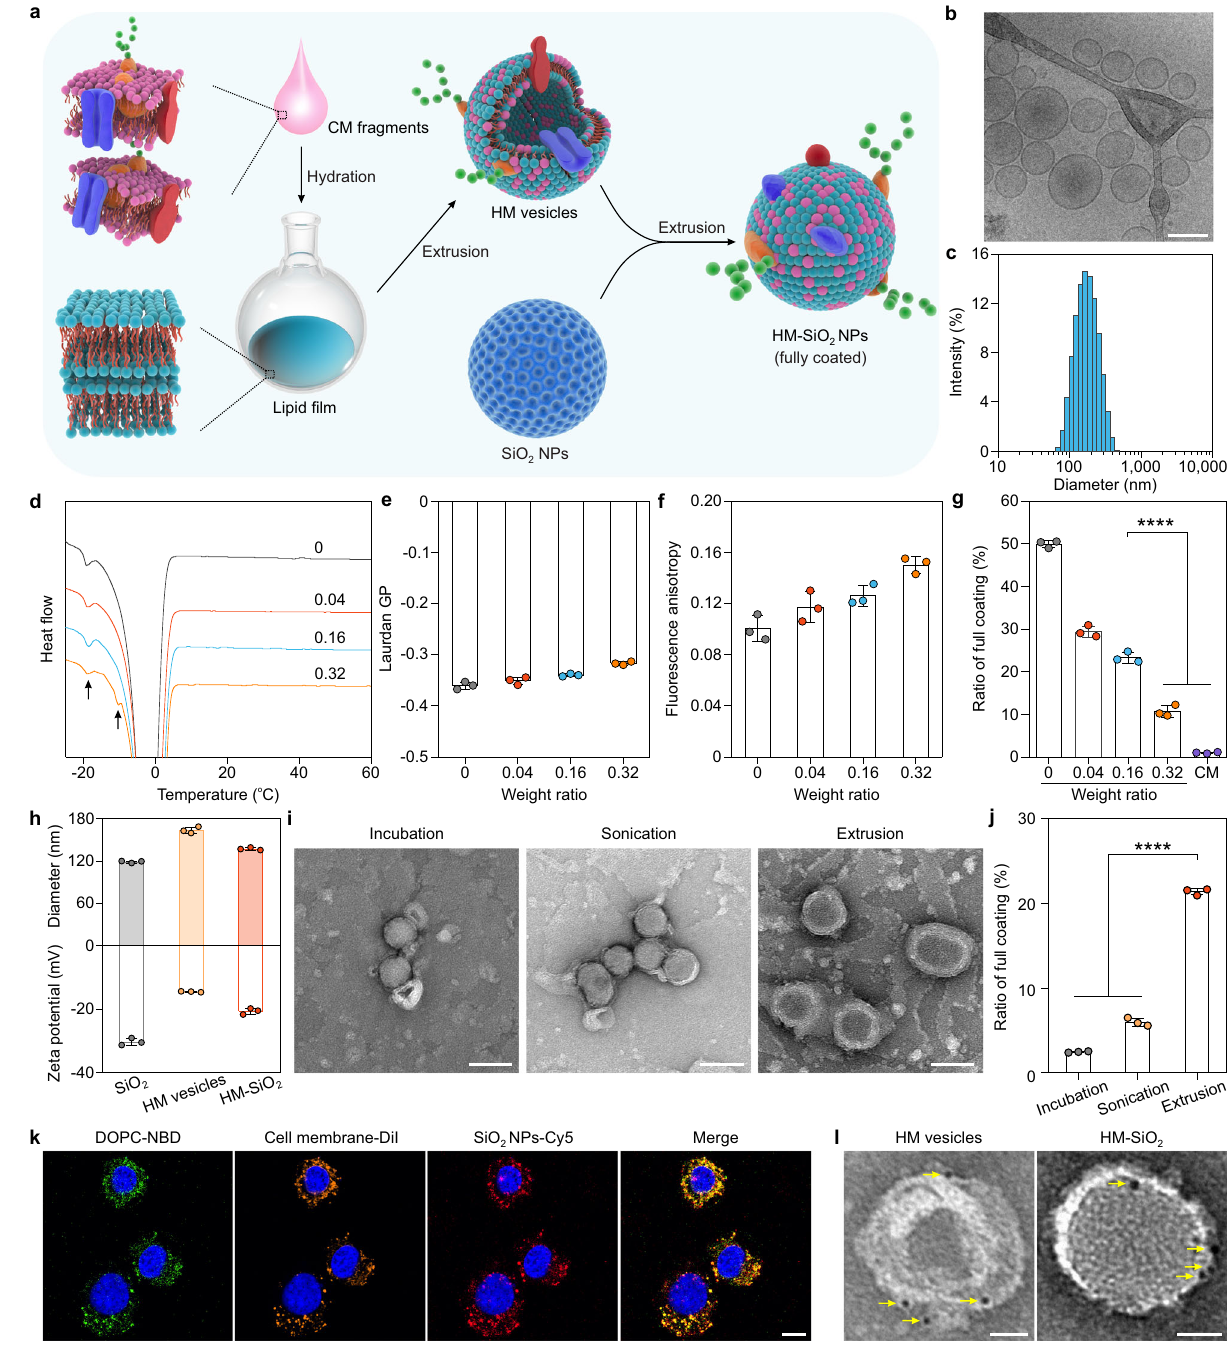
Fig. 4 | Preparation and characterization of HM-SiO 2 NPs. a Schematic showing the process of developing fully coated HM-SiO 2 NPs. b Cryo-TEM image of HM vesicles.Scalebar,100nm. c SizedistributionofHMvesicles. d DSCanalysisofHM vesicles prepared with CM protein/DOPC lipid weight ratios of 0, 0.04, 0.16, and 0.32. Typical peaks are indicated by black arrows. e , f Effects of CM incorporation on the laurdan GP ( e ) and fl uorescence anisotropy ( f ) values of HM vesicles pre- pared at different weight ratios (protein/lipid). g Quanti fi cation of the ratio of full CMcoatingforSiO 2 NPscoatedwithHMvesiclesofdifferentweightratios(protein/ lipid) and the plain CM coating with the same amount of CM protein (0.4mg/mL) used in the HM coating. h Mean diameters and zeta potentials of SiO 2 NPs, HM vesicles, and HM-SiO 2 NPs. i TEM images of HM-SiO 2 NPs fabricated by incubation, sonication,andextrusion.Scalebars,100nm. j Quanti fi cationoftheratiooffullCM